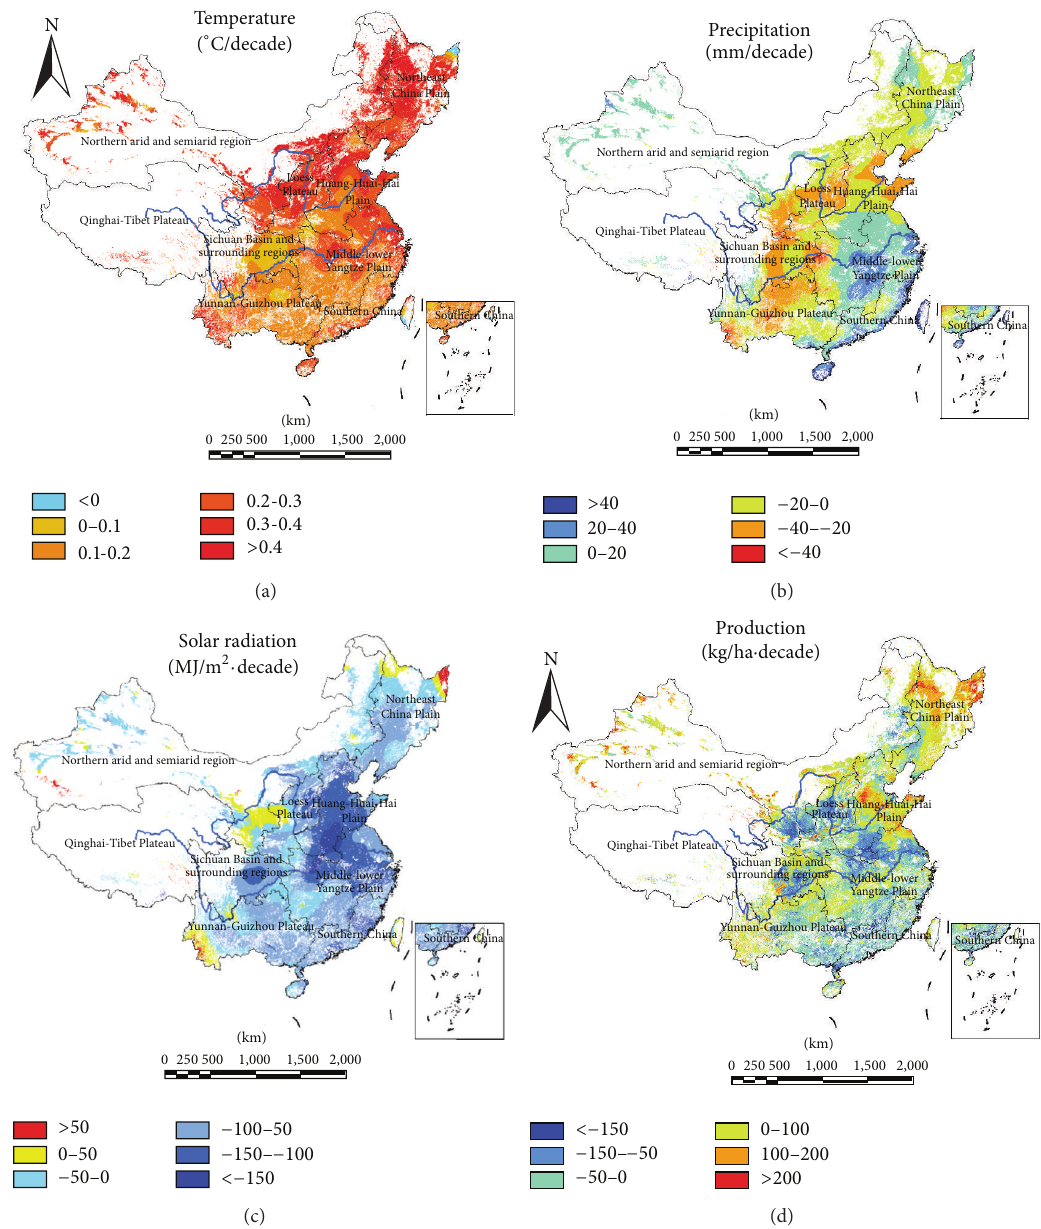
Figure 6: Changes in climatic factors and production potential during the past five